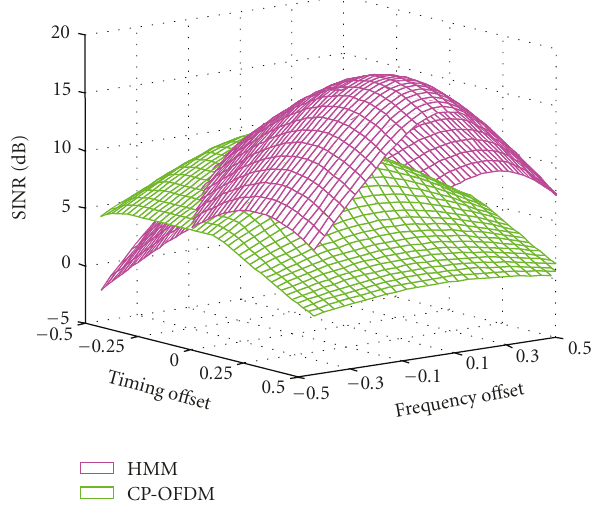
Figure 4: E ff ects of TO and CFO on SINR for hexagonal multicarrier system with τ rms f d = 0 . 02 at SNR = 30 dB.